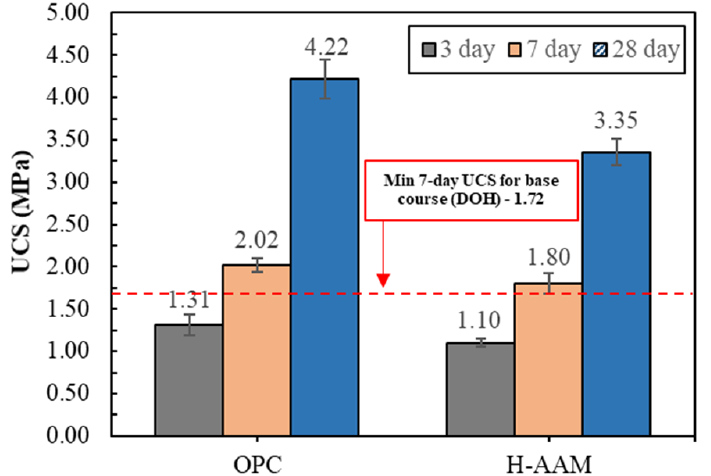
Figure 1. UCS results of road base materials stabilized by Portland cement and the H-AAM obtained during the preliminary study.